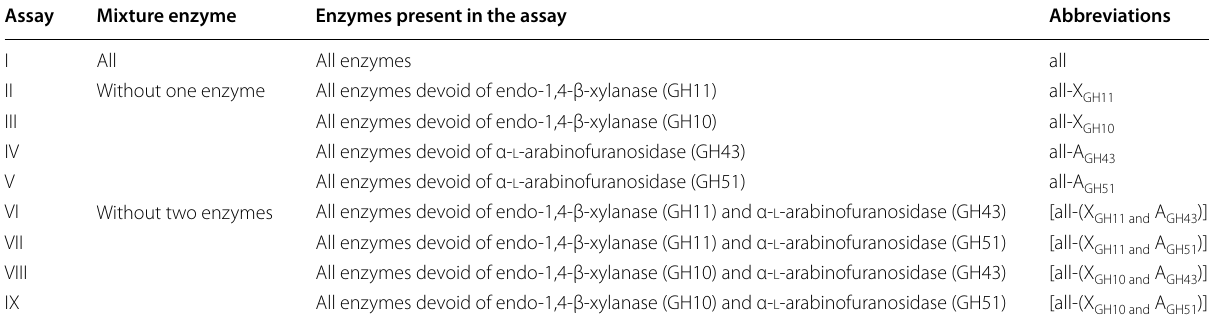
Table 2 Definition of the addition of enzymes and nomenclature of the tests carried out to evaluate the synergistic effect Assay Mixture enzyme Enzymes present in the